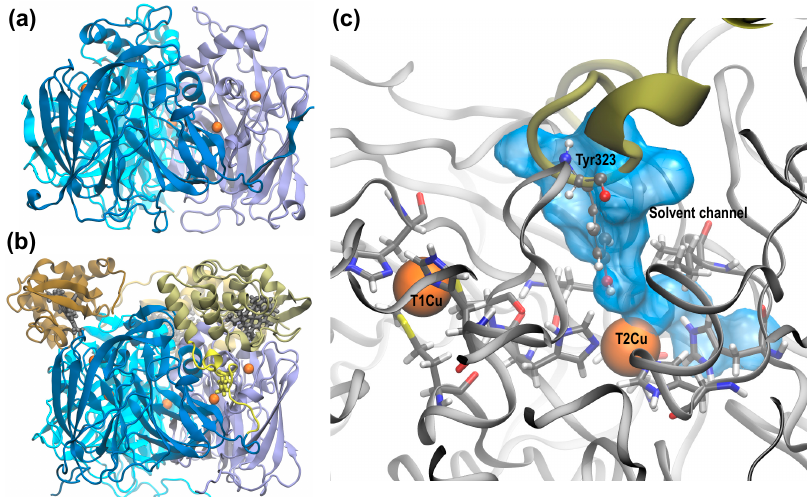
Figure 1. Structural similarities in two domain Achromobacter cycloclastes CuNiR ( Ac NiR) and three domain Rp NiR: ( a ) Structure of Ac NiR, PDB ID: 2BW4. ( b ) Structure of Rp NiR, PDB ID: 3ZIY. The T1